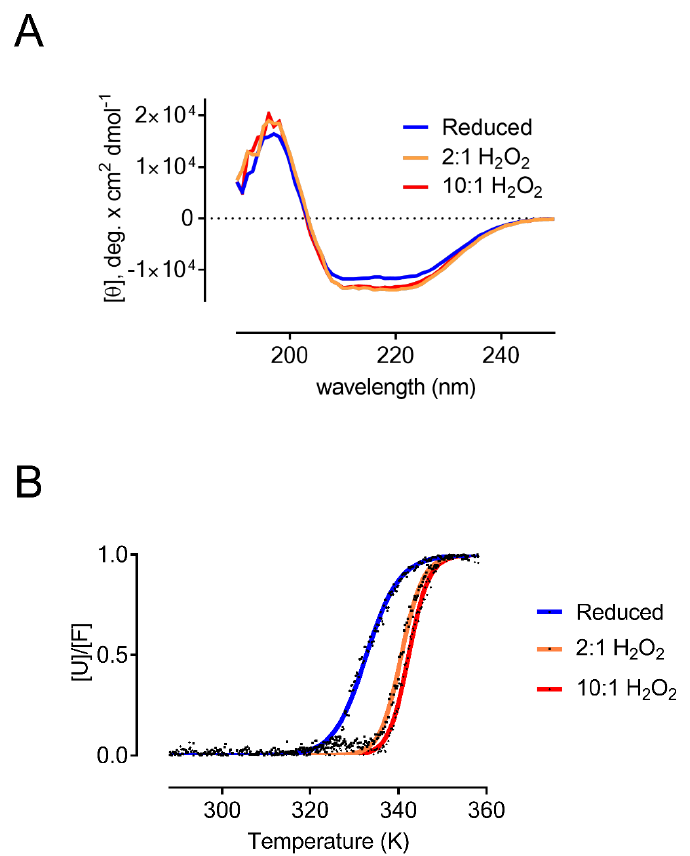
Figure 2. Oxidation does not influence the secondary structure of AtDJ-1B but increases its thermostability. ( A ) Comparative CD spectra of AtDJ-1B reduced with TCEP (blue trace), and DJ-1B oxidized by treatment with either a 2-fold (orange) or 10-fold (red) molar excess of H 2 O 2 . A slight spectral shift can be observed for the H 2 O 2 -treated protein relative to the reduced protein, though this spectral difference does not ultimately relate to any significant change in secondary